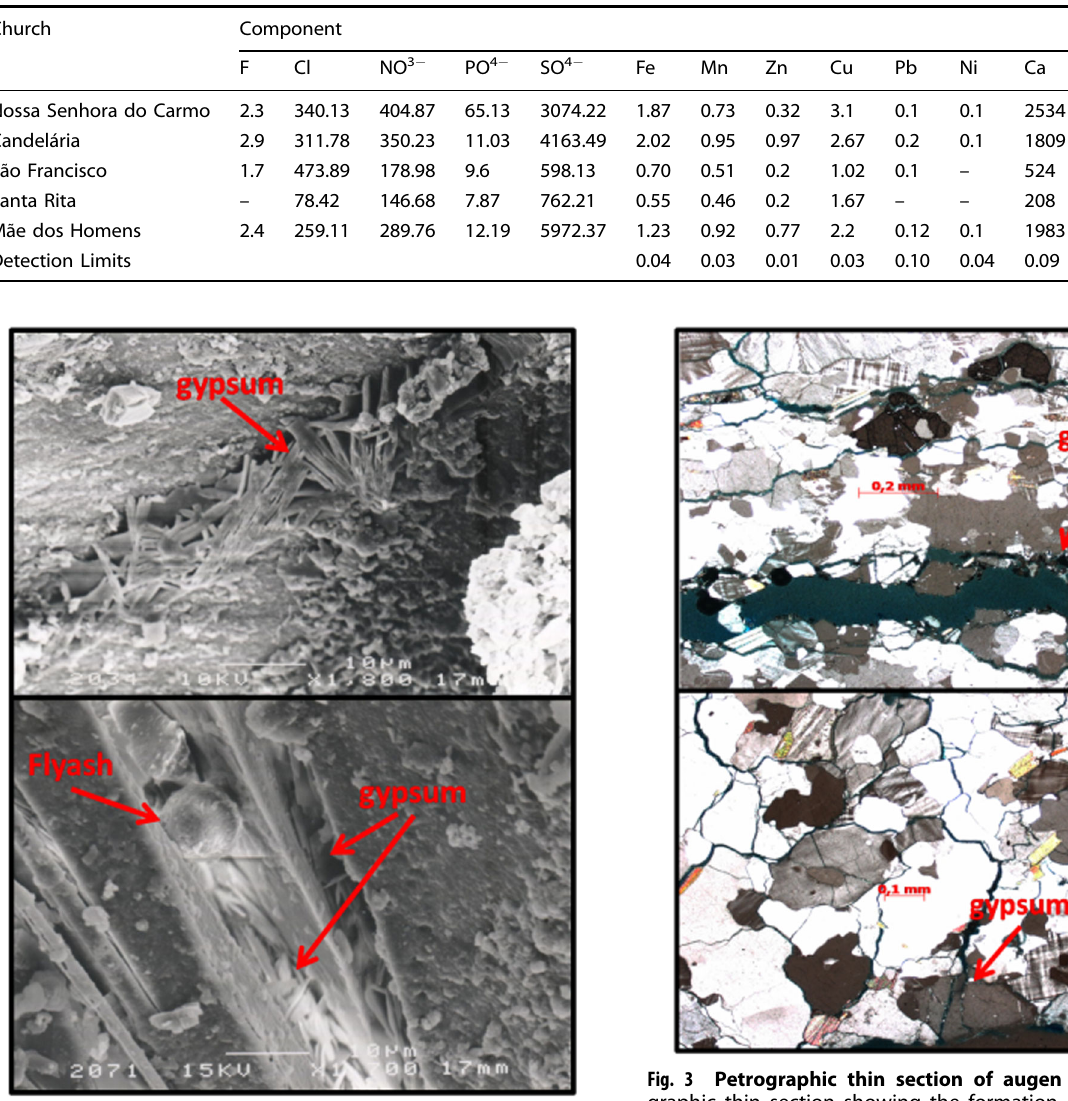
Fig. 2 Scanning electron micrographs of black crust. SEM micrographs of black crusts on the augen gneiss facade of a church in Rio de Janeiro, Brazil, showing needle-like crystals of gypsum accumulated in the stone facade; fl y ash is also shown.